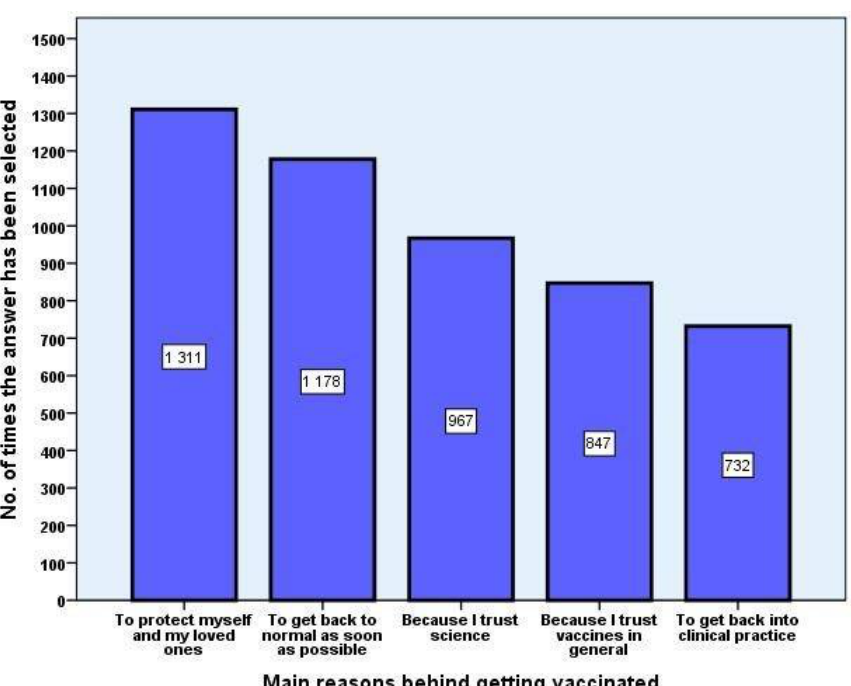
Figure 1. Main reasons for acceptance of COVID-19 vaccines. The top five most commonly chosen answers from a list of multiple pre-established ones were selected to visually represent the absolute frequency amongst replies.